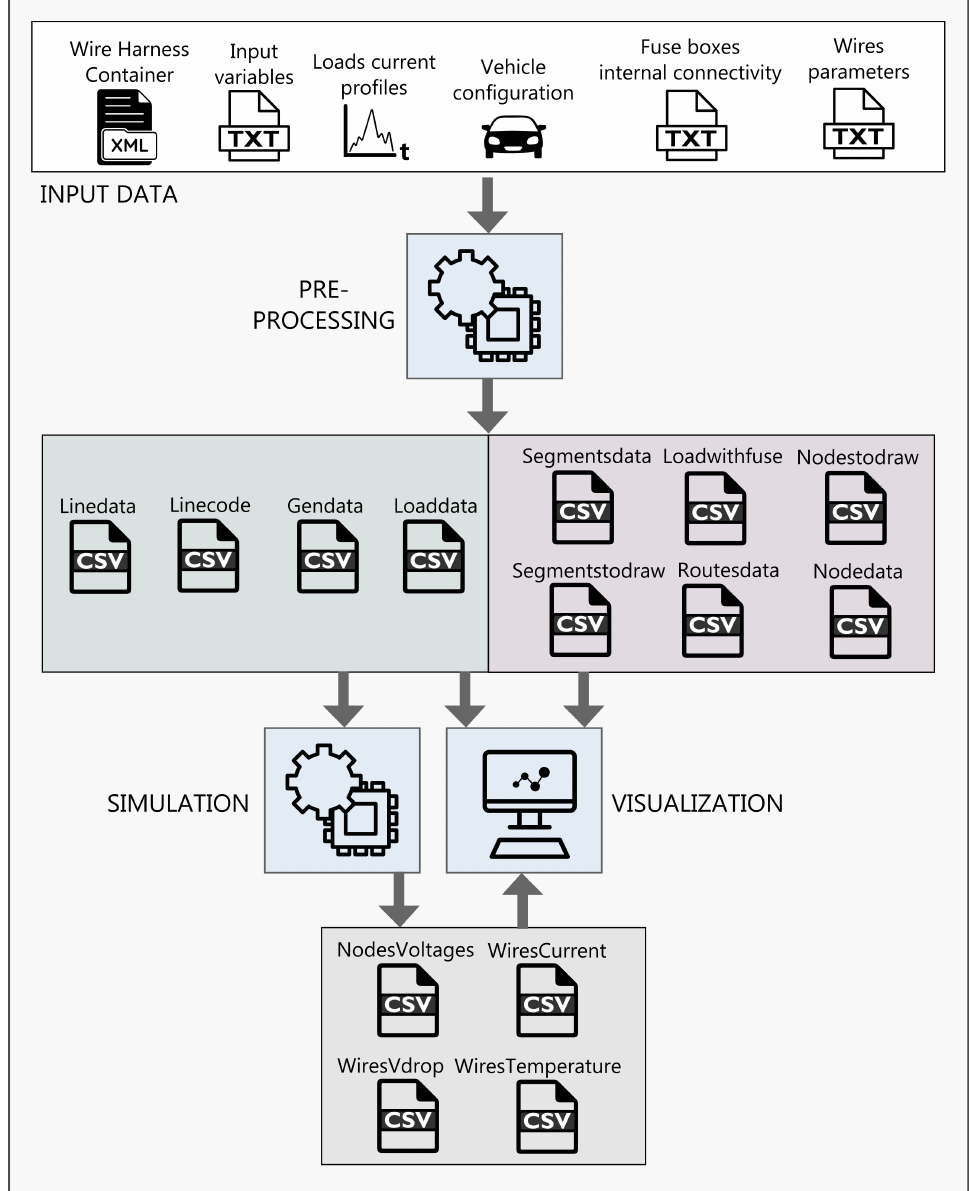
Figure 3. Data generation